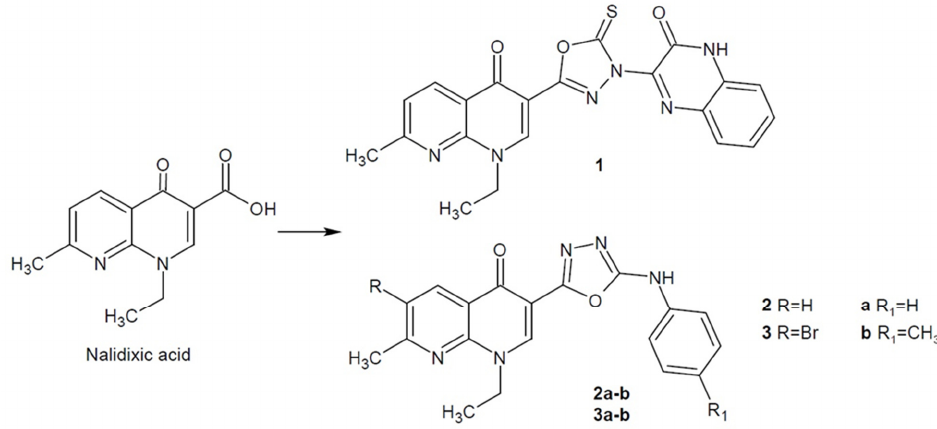
Figure 2. 1,3,4-oxadiazole hybrids of nalidixic acid with antibacterial activity.